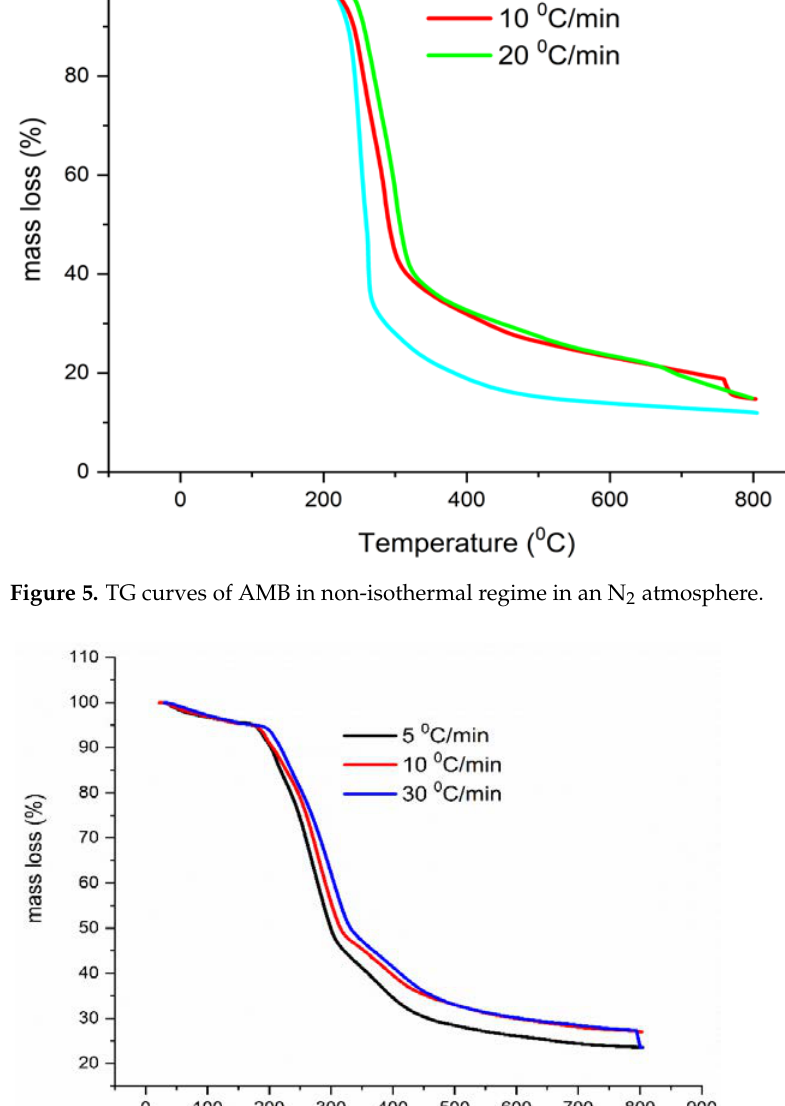
Figure 6. T G curves of FT in non-isothermal regime in an N 2 atmosphere .